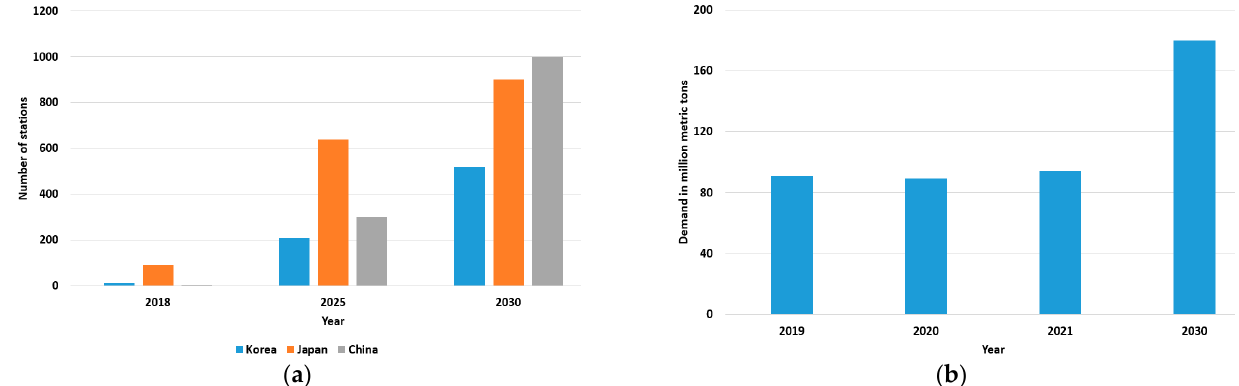
Figure 2. ( a ) Cumulative number of hydrogen fueling stations from 2018 to 2030; ( b ) Hydrogen demand worldwide from 2019 to 2021 with forecast for 2030.